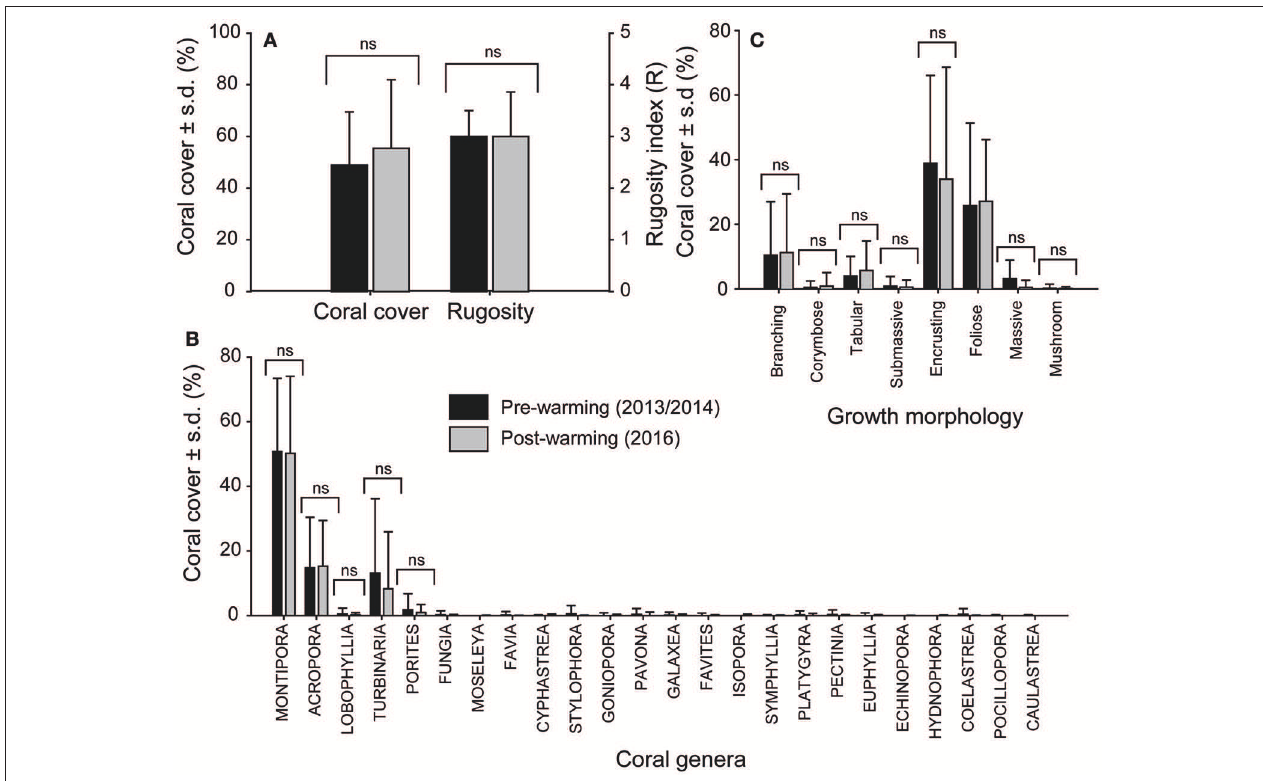
FIGURE 4 | Pre- (black) and post-warming (gray) comparisons of coral assemblages at Paluma Shoals reef complex. Plots show: (A) average ( ± s.d.) coral cover and rugosity, (B) the proportion of coral growth morphologies within communities, and (C) the prevalence of different coral genera (24 identified) observed in both survey time-series (July 2013/2014 and August 2016). ns, no significant difference between surveys.